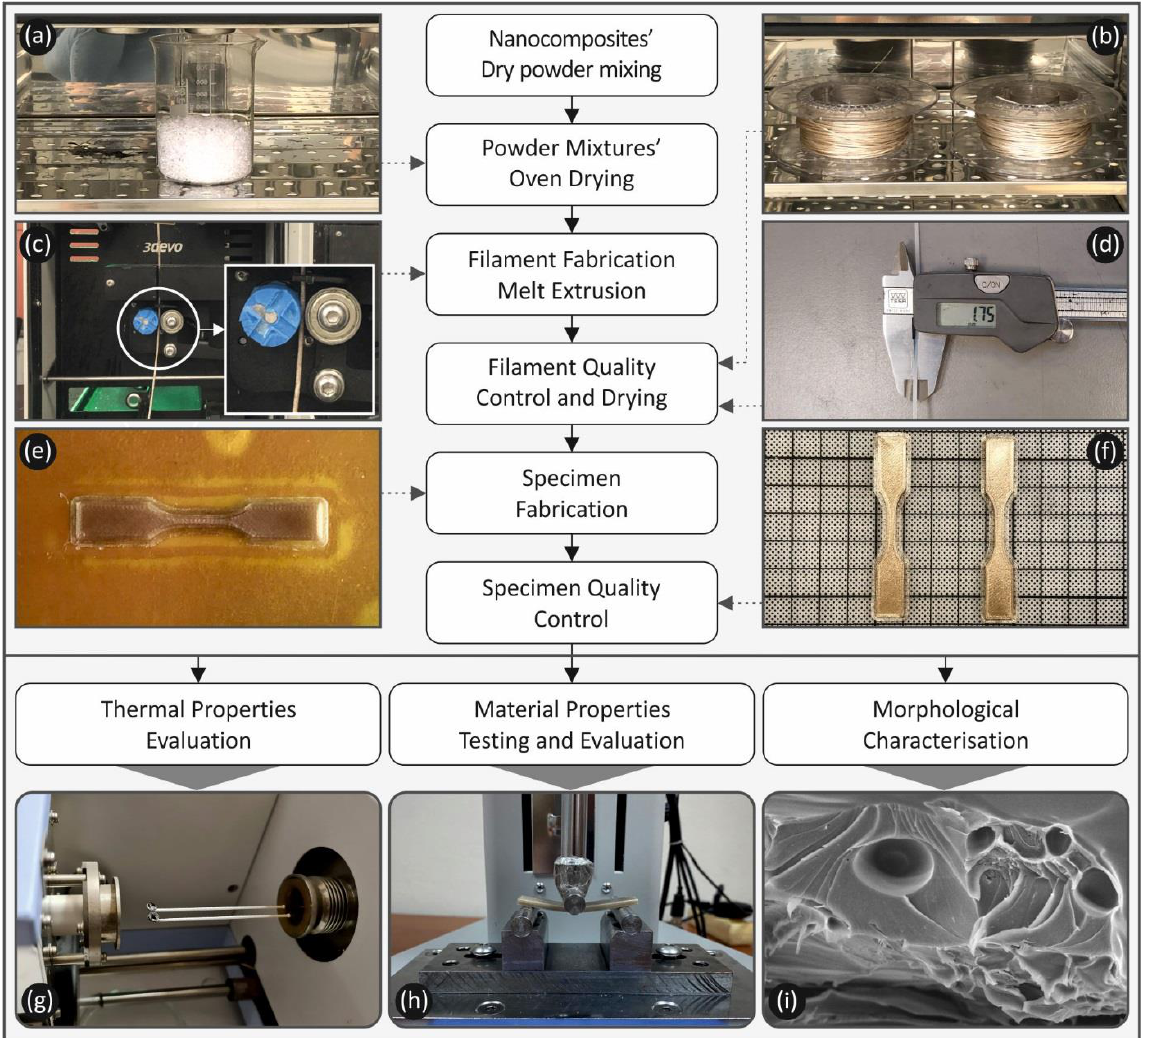
Figure 1. A graphical presentation of the processing workflow adopted in this study, from filament fabrication to specimens’ fabrication, testing, and characterization: ( a ) PC polymer drying process, ( b ) Filaments drying process, ( c ) Extrusion process for filament fabrication, ( d ) Filament quality control, ( e ) 3D-printed tensile test specimens’ fabrication, ( f ) 3D-printed tensile test specimens’ quality control, ( g ) Thermogravimetric analysis of the samples, ( h ) Three-point bending test on the specimens, and ( i ) Scanning Electron Microscopy on the fracture surface of the tensile test specimens.